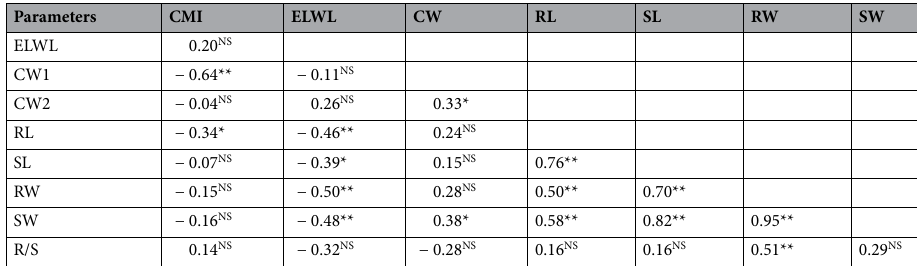
Table 4. Pearson correlation among morphological parameters of the sunflowers under osmotic stress regime: cell membrane injury (CMI%), excise leaf water loss (ELWL) cuticular waxes under control (CWµ g g −1 ),cuticular waxes under stress (µ g g −1 ) (CW2), root length (RL (cm)), shoot length (SL (cm)), root weight (RW g −1 ) and shoot weight (SW g −1 ). *Significant to P ≤ 0.05. **Significant to P ≤